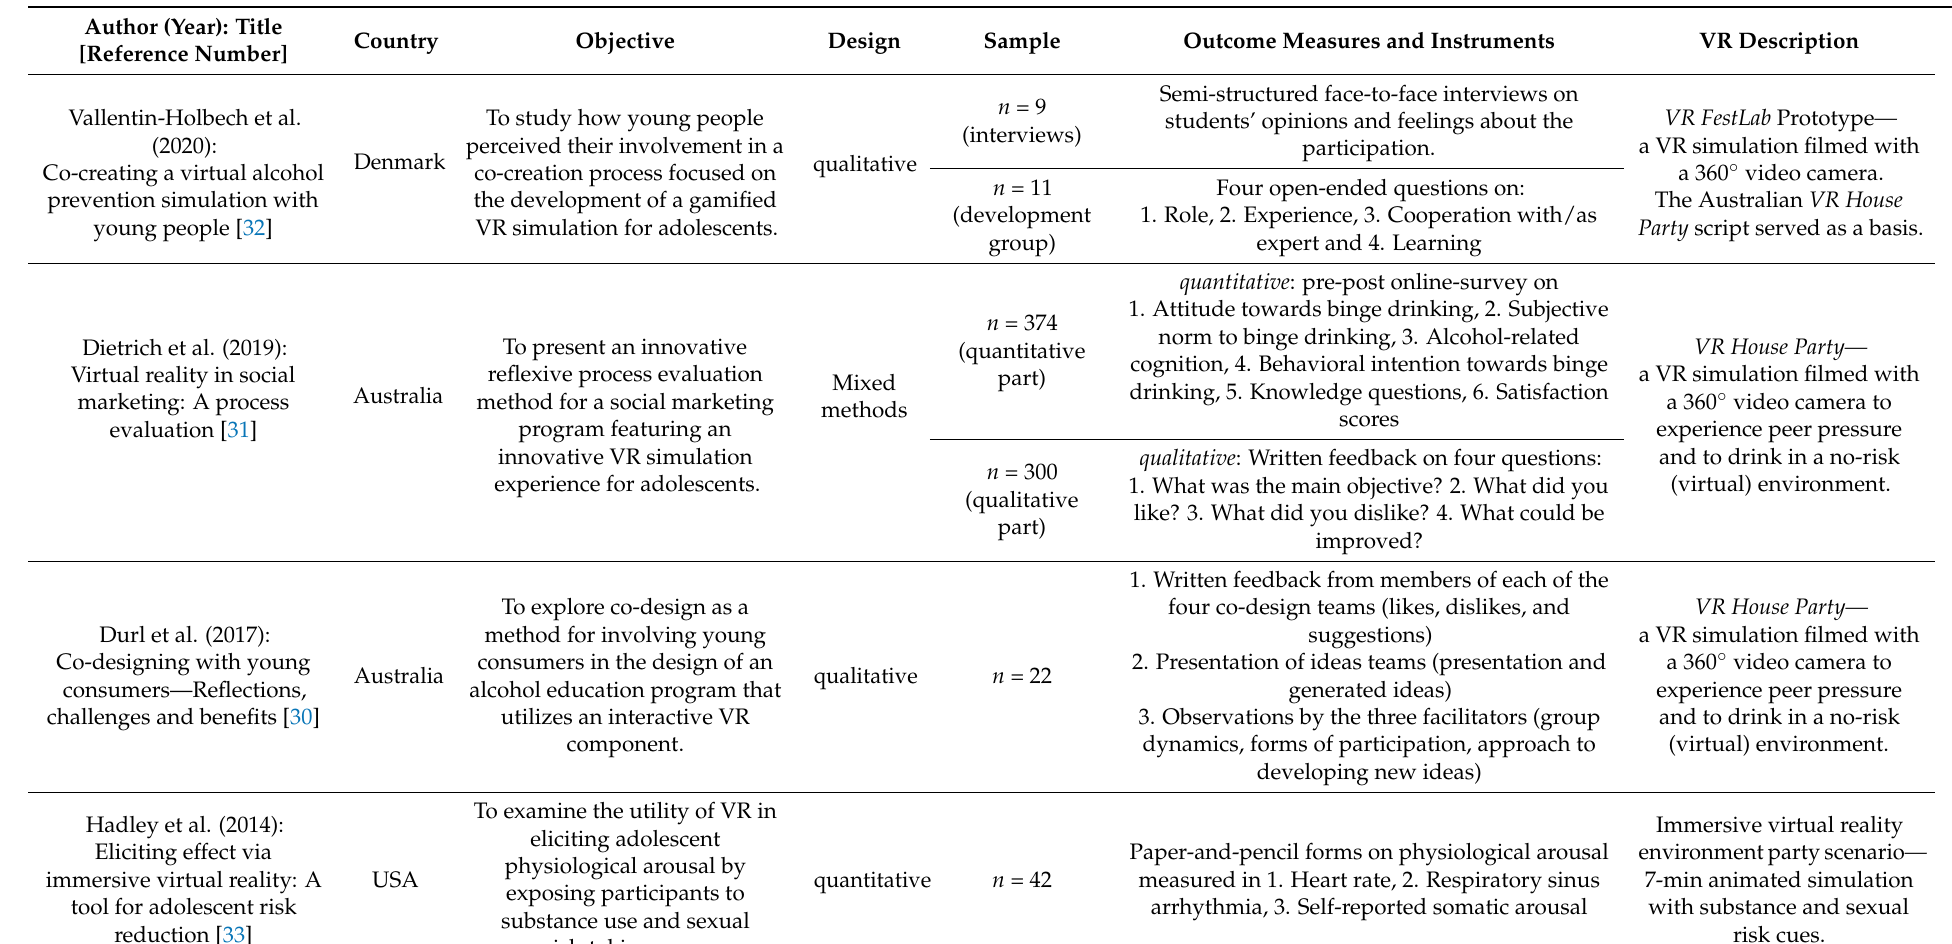
Table 1. Overview of study characteristics of included